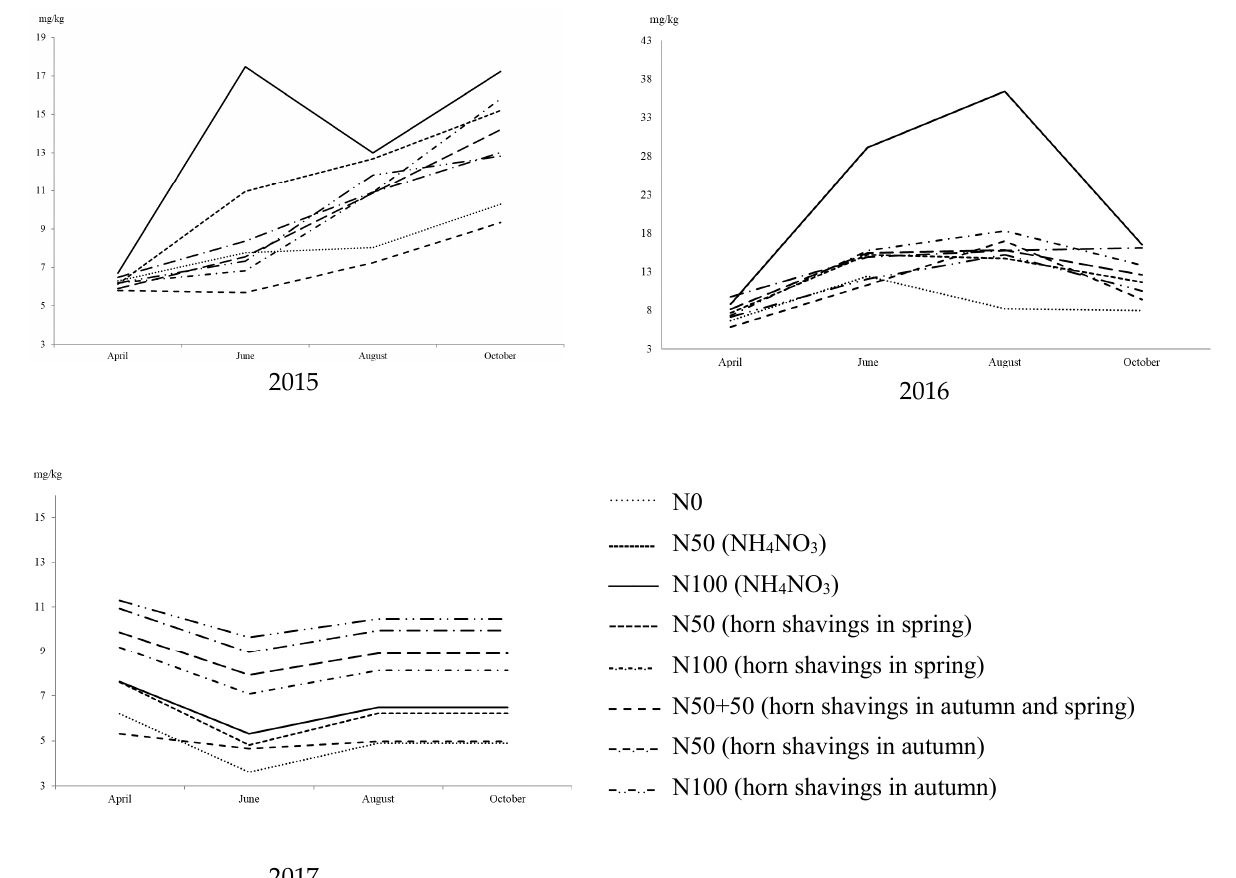
Figure 1. Dynamics of mineral nitrogen content in the soil. Babtai, 2015–2017.